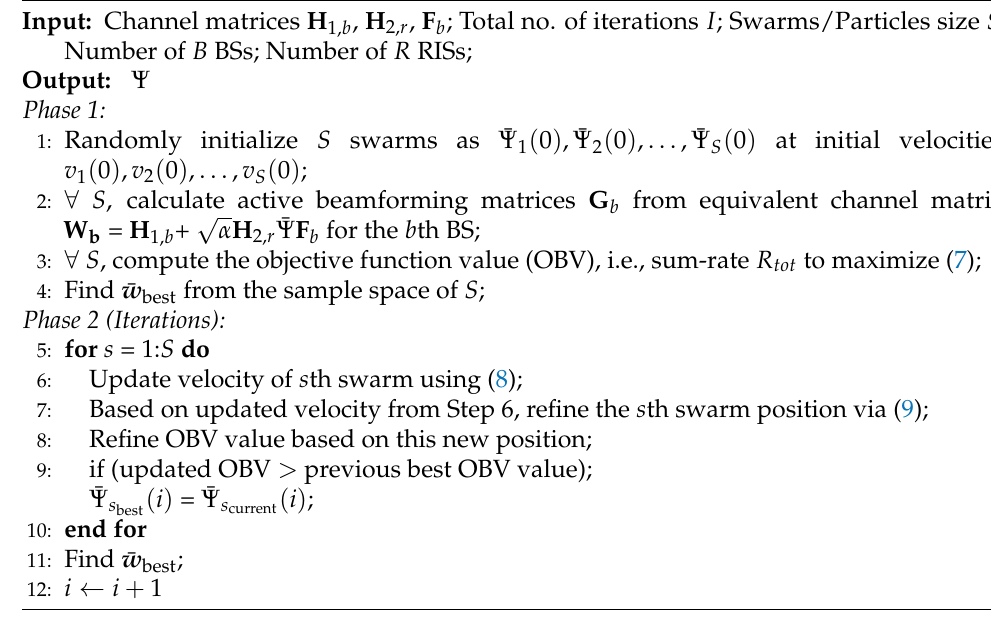
Algorithm 1 Passive beamforming design based on